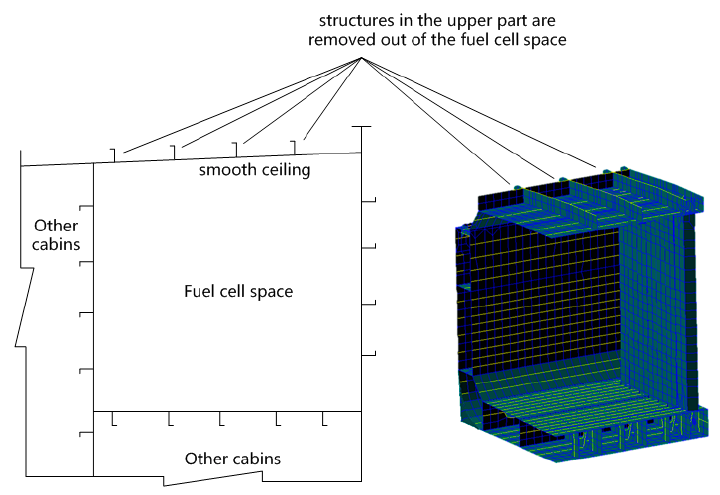
Figure 6. Schematic design of fuel cell space.